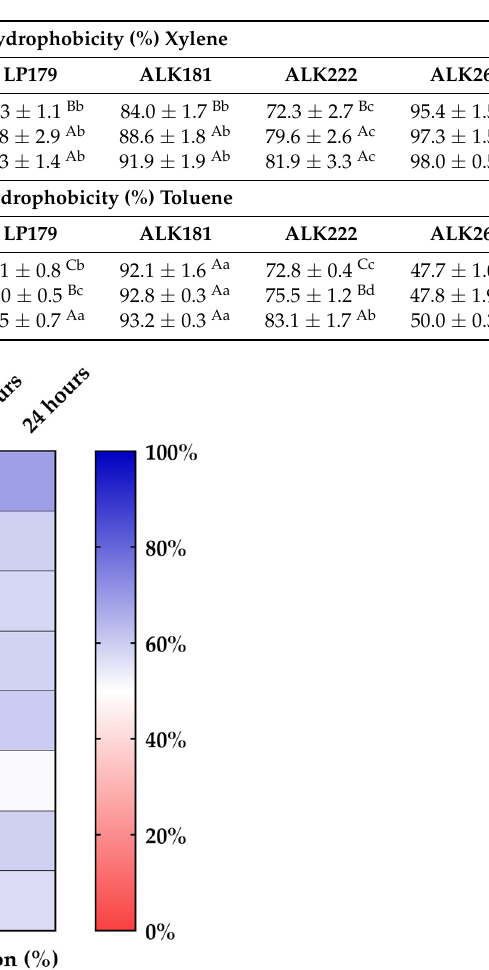
Table 2. Adhesion to toluene and xylene of the Lactiplantibacillus plantarum and Apilactobacillus kunkeei tested strains (LP 31, LP 42, LP 148, LP 179, ALK 181, ALK 222, ALK 268 and ALK 385) after different contact times. The data (mean ± SD; n = 3) were expressed as percentage of hydrophobicity, different lowercase letters in each row and uppercase letters in each column indicate significant differences ( p < 0.05).